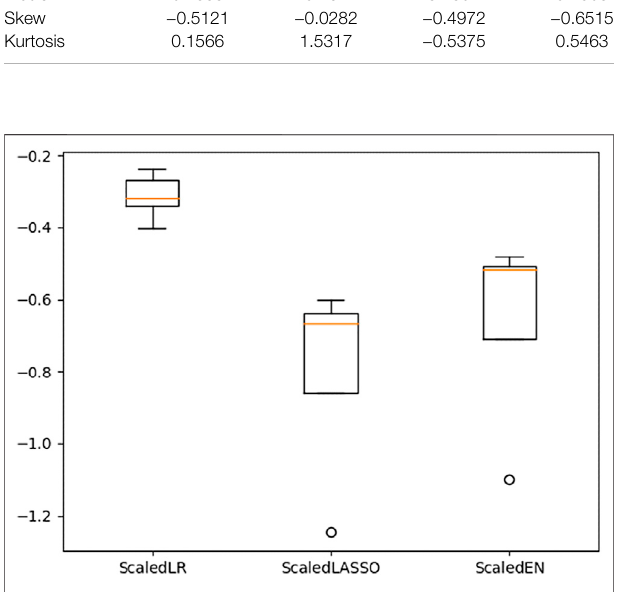
FIGURE 3 | Linear models